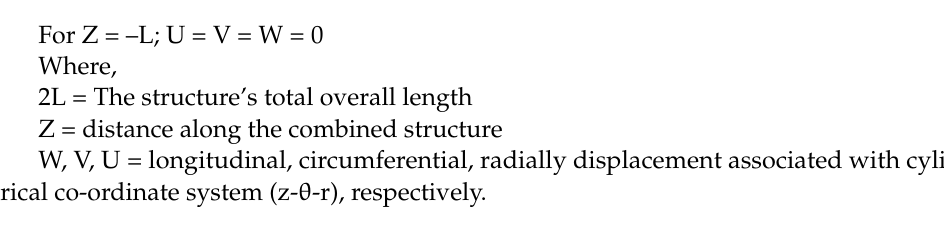
Figure 1. Discretized cylindrical socket joint layout.